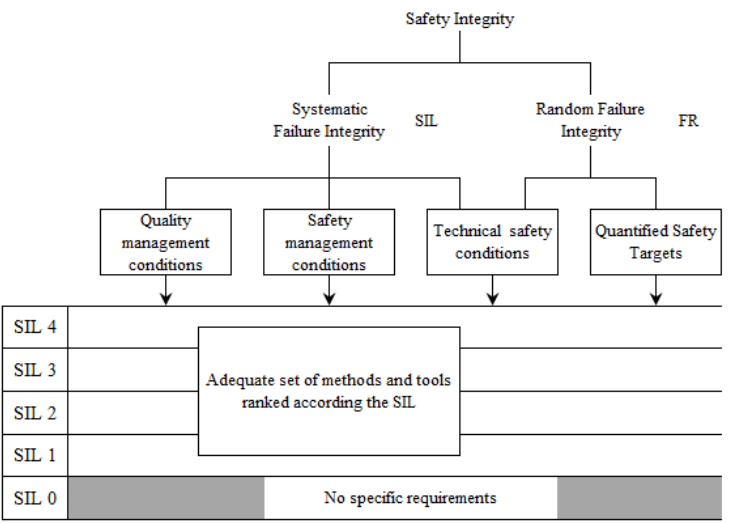
Fig. 7. Relationship between SILs and techniques in EN